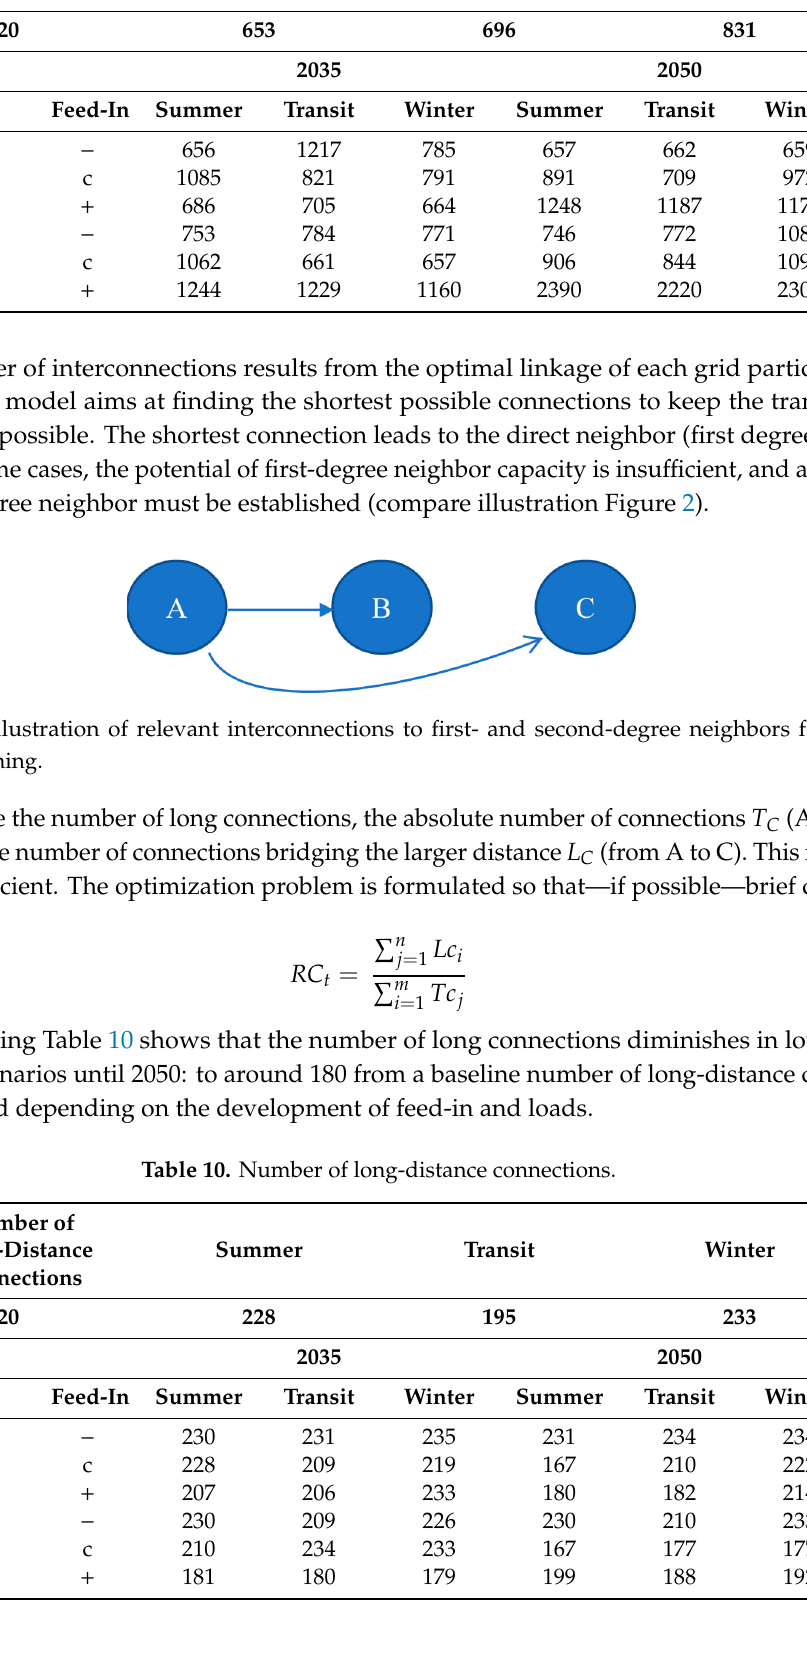
Table 11. RC t ratio of long-distance connections.